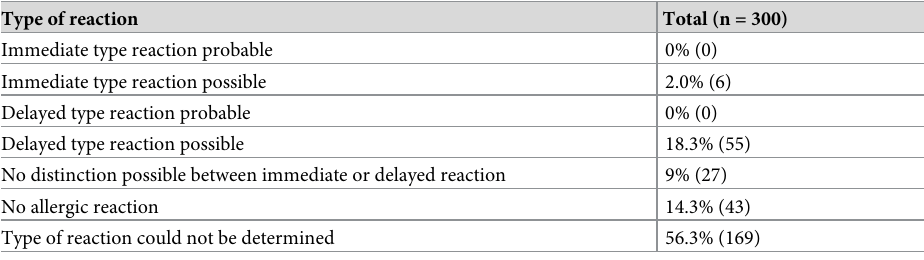
Table 3. Type of allergic reaction according to modified checklist of Salden �